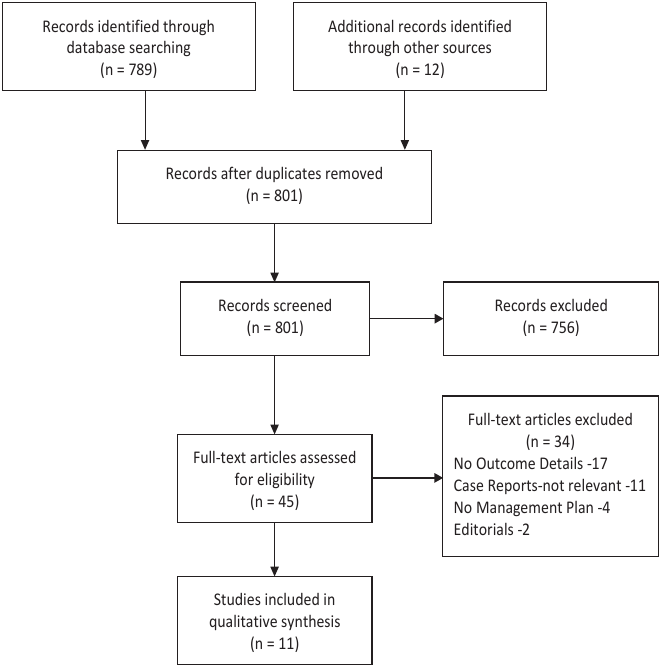
Figure 1. PRISMA flow